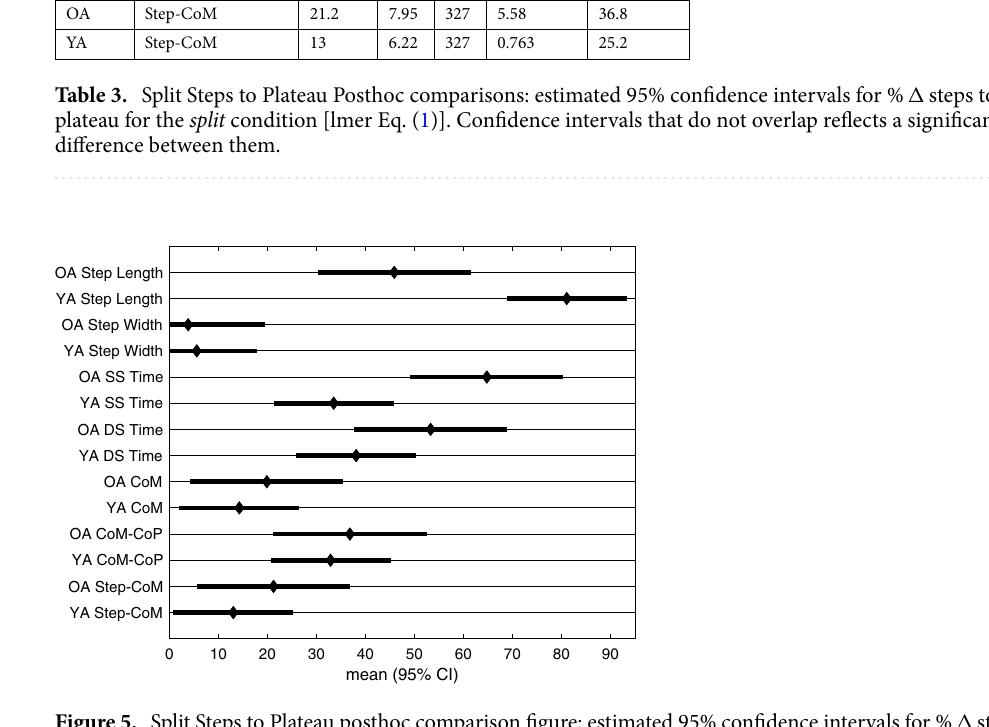
Figure 5. Split Steps to Plateau posthoc comparison figure: estimated 95% confidence intervals for % (cid:31) steps to the plateau for the split condition [lmer Eq. (1)]. Confidence intervals that do not overlap reflects a significant difference between them.